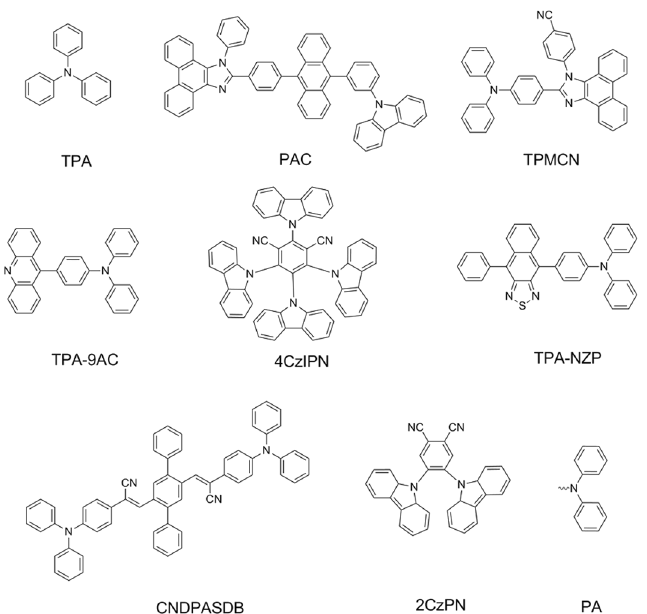
Figure 1. Molecular structures extracted from